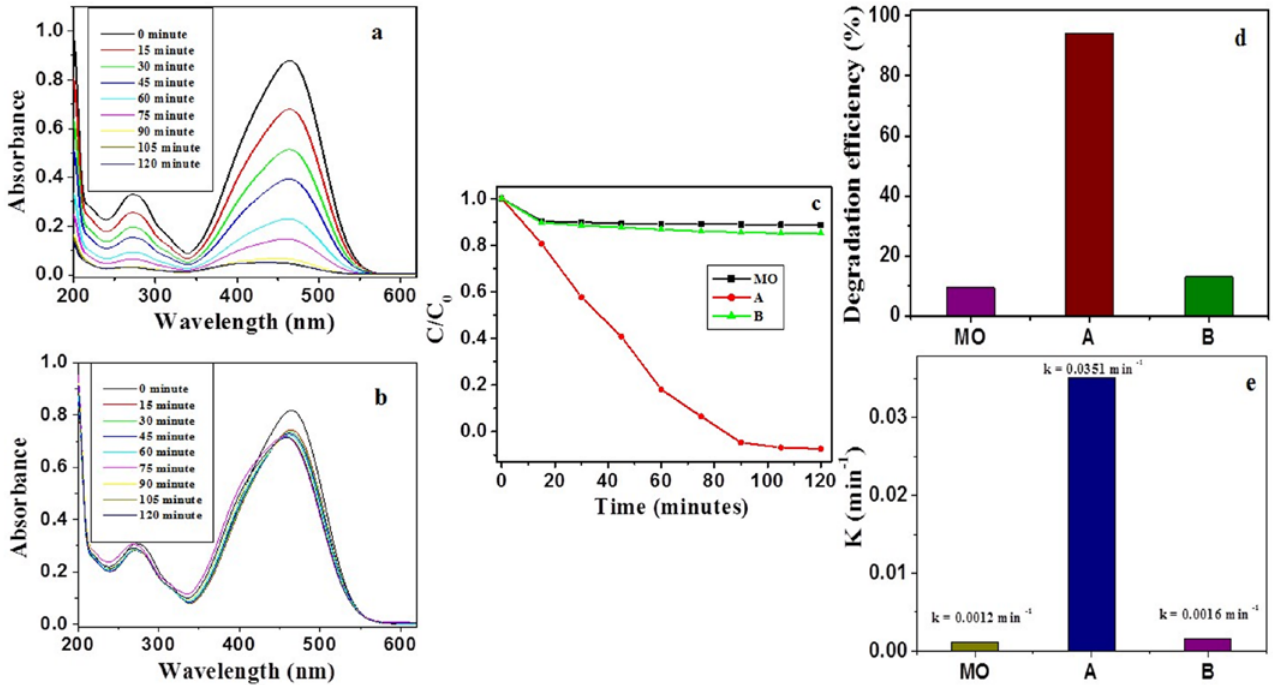
Figure 4. Changes in the UV-Vis absorption spectrum of methyl orange with 50 mg β -Nb 2 ZnO 6 ( A and B ) after different irradiation times ( a , b ), photocatalytic activities of β -Nb 2 ZnO 6 nanoparticles ( A and B ) for methyl orange degradation over 120 min ( c ), degradation efficiency of β -Nb 2 ZnO 6 nanoparticles ( A and B ) ( d ) comparison of rate constants ( e ).